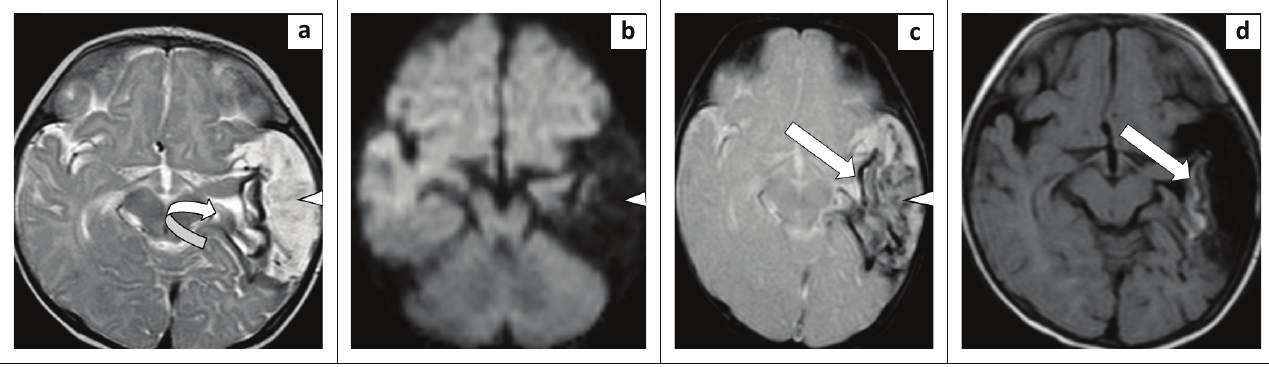
FIGURE 3: Follow-up axial MRI brain at 6 months of age. T2-weighted (a), diffusion-weighted imaging (DWI) (b), gradient recalled echo (GRE) (c) and T1 weighted (d) demonstrate resolution of the subpial haemorrhage with cystic encepahalomalacia and haemosiderin staining (arrowhead). Associated underlying temporal lobe volume loss (curved arrow). Gyriform T1 hyperintensity and blooming on GRE suggested left temporal cortical laminar necrosis with haemosiderin deposition